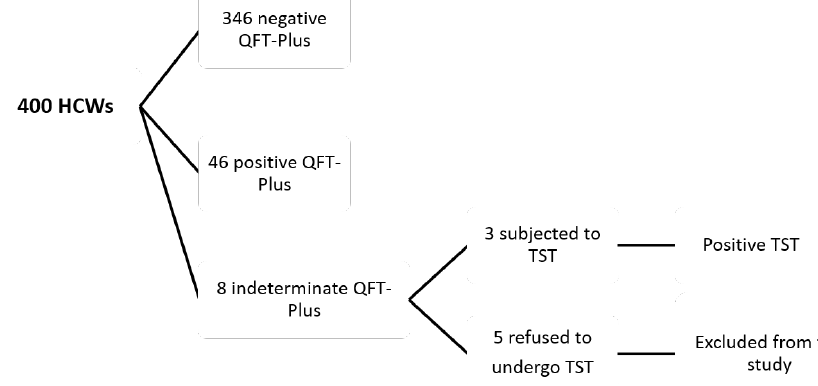
Figure 1. Flowchart of the studied